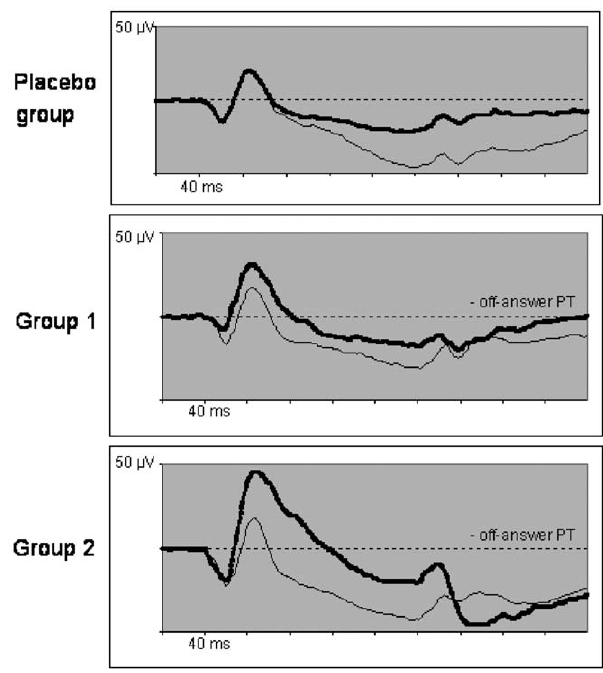
Figure 6. Mean ON-OFF-ERG. Recordings of each group for baseline (thin line) and 4 hours after treatment (thick line). In group 1 the recordings of only 4 of 6 probands were considered due to unrecognizable OFF-answers in 2 probands. An increase of on-answer amplitude in both treated groups seems obvious but was statistically not significant. However, there was a significant reduction of OFF- answer peak time (PT) in both treated groups 4 hours after treatment.